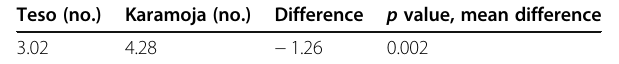
Table 3 Differences in the magnitude of the decline in the number of cattle sold before and during the COVID-19 lockdown by region